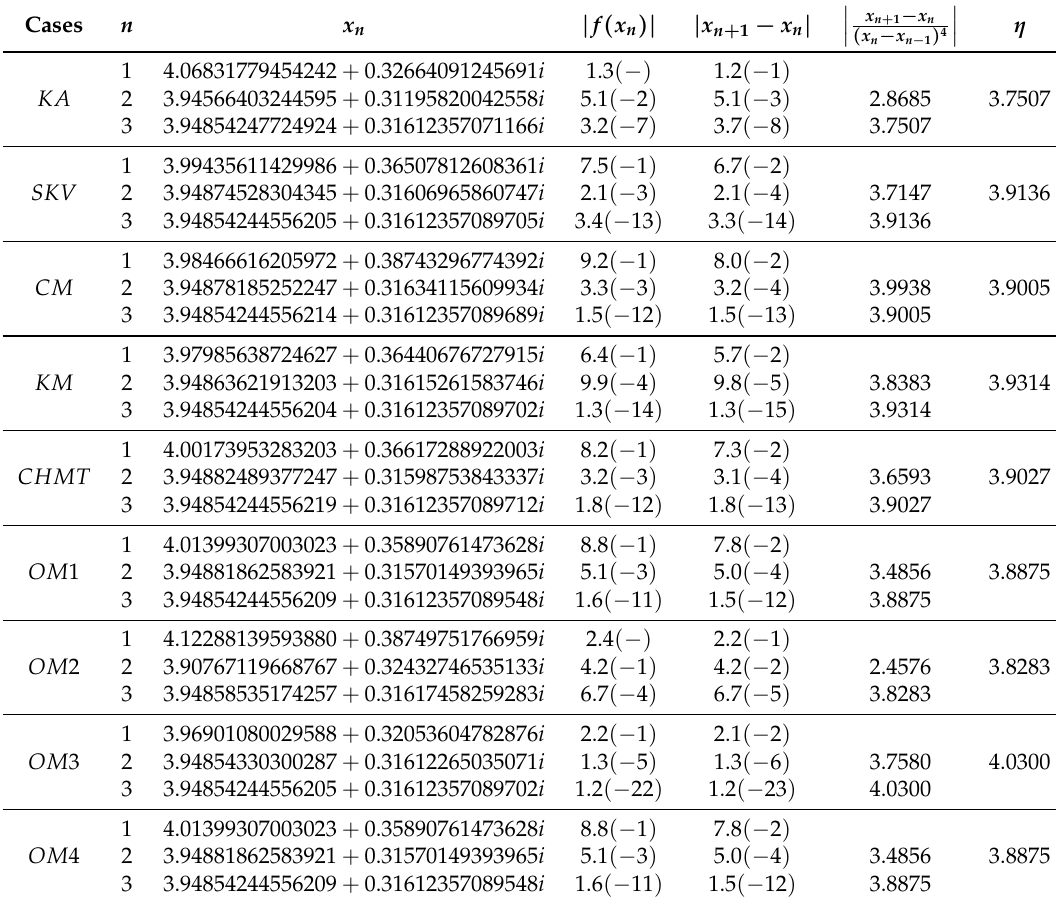
Table 4. Convergence behavior of the different fourth-order optimal methods for f 2 ( x )